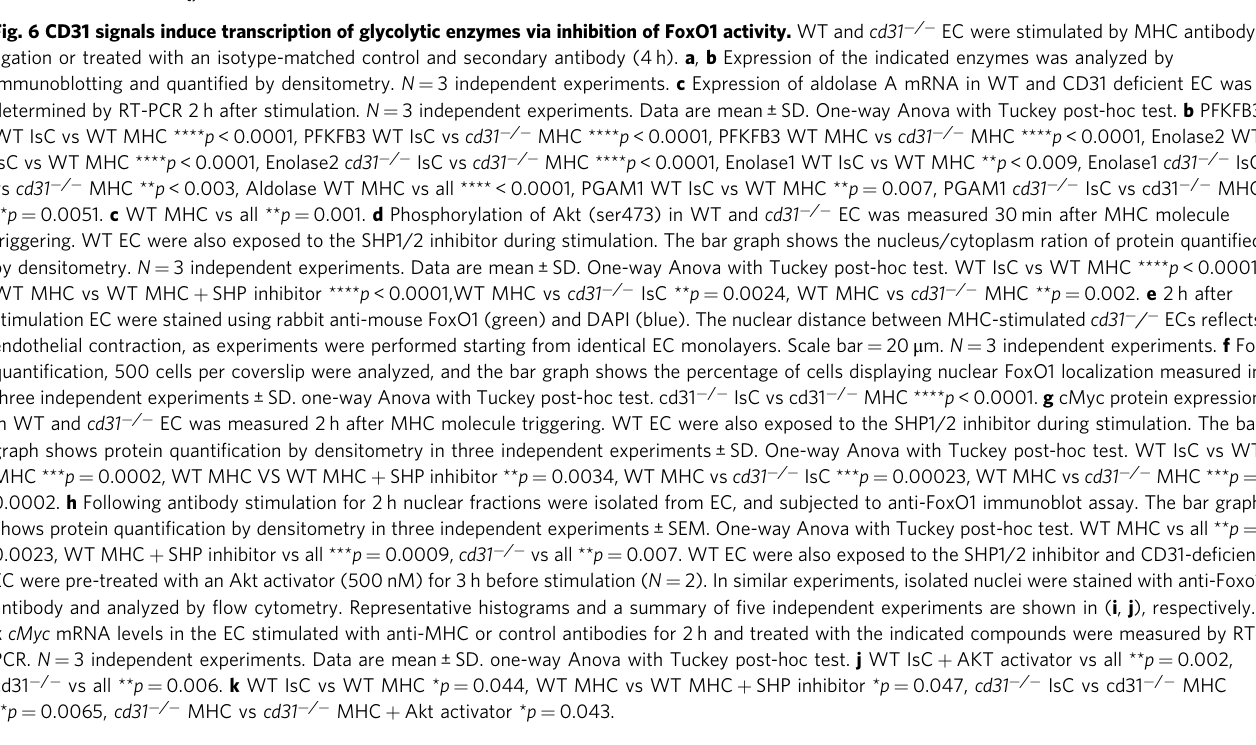
0.0002. h Following antibody stimulation for 2 h nuclear fractions were isolated from EC, and subjected to anti-FoxO1 immunoblot assay. The bar graph shows protein quanti fi cation by densitometry in three independent experiments ± SEM. One-way Anova with Tuckey post-hoc test. WT MHC vs all ** p = 0.0023, WT MHC + SHP inhibitor vs all *** p = 0.0009, cd31 − / − vs all ** p = 0.007. WT EC were also exposed to the SHP1/2 inhibitor and CD31-de fi cient EC were pre-treated with an Akt activator (500 nM) for 3 h before stimulation ( N = 2). In similar experiments, isolated nuclei were stained with anti-Foxo1 antibody and analyzed by fl ow cytometry. Representative histograms and a summary of fi ve independent experiments are shown in ( i , j ), respectively. k cMyc mRNA levels in the EC stimulated with anti-MHC or control antibodies for 2 h and treated with the indicated compounds were measured by RT- PCR. N = 3 independent experiments. Data are mean ± SD. one-way Anova with Tuckey post-hoc test. j WT IsC + AKT activator vs all ** p = 0.002, cd31 − / − vs all ** p = 0.006. k WT IsC vs WT MHC * p = 0.044, WT MHC vs WT MHC + SHP inhibitor * p = 0.047, cd31 − / − IsC vs cd31 − / −